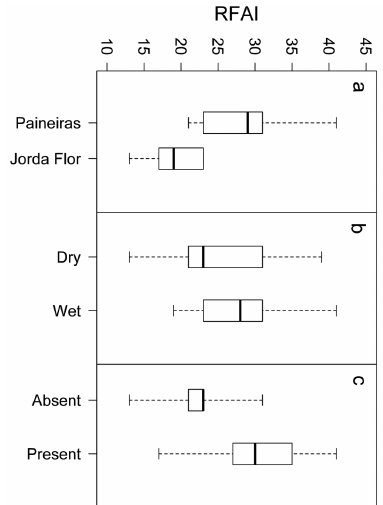
Figure 3. Distribution (median, 25 th and 75 th percen- tiles, and extreme values) of the RFAI index comparing the reservoirs (a), seasons (b) and presence of riparian vegetation (c).